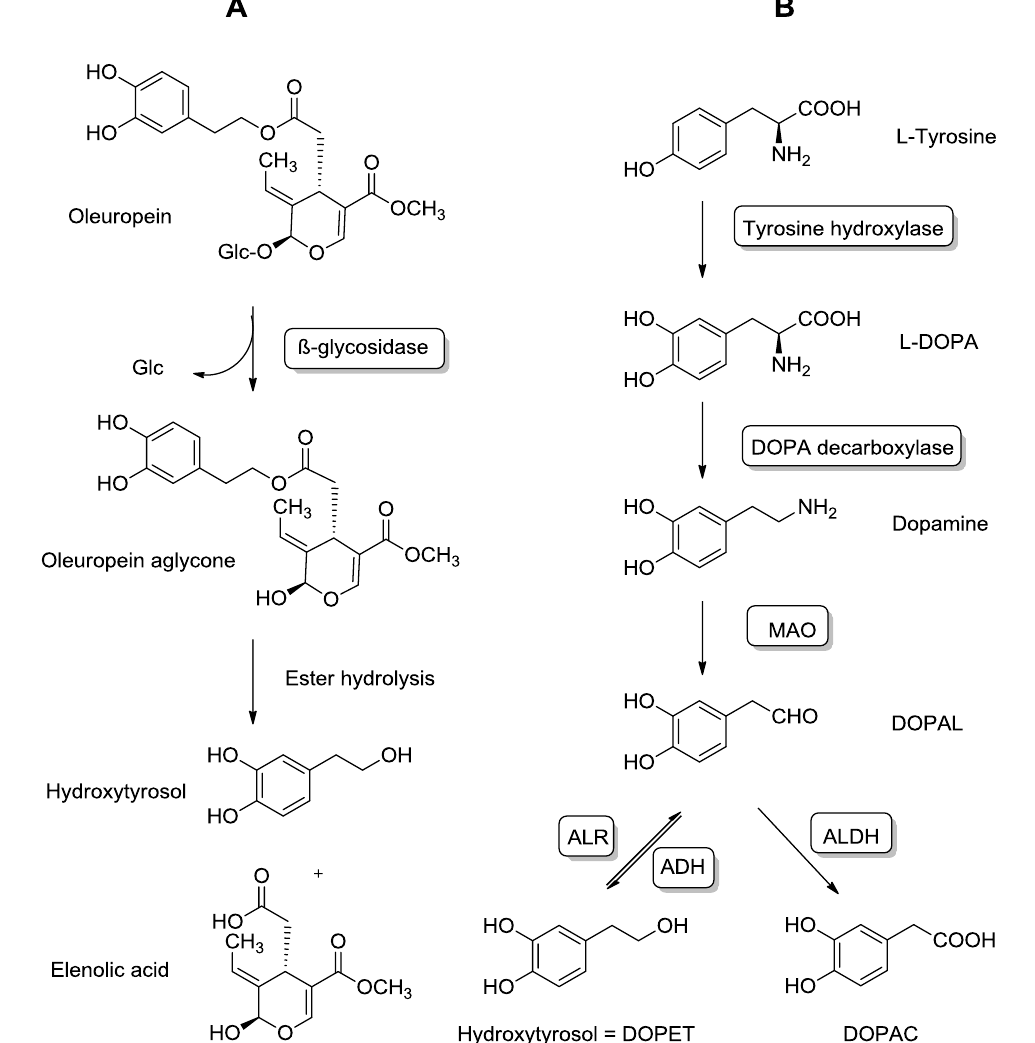
Figure 2. Comparison between exogenous and endogenous sources of hydroytyrosol (HT). ( A ) Origin of HT from oleuropein. Oleuropein hydrolysis results in oleuropein aglycone, whose subsequent hydrolysis originates elenolic acid and HT. ( B ) Endogenous formation of HT via dopamine oxidative metabolism. Abbreviations: ALR: Aldehyde/aldose